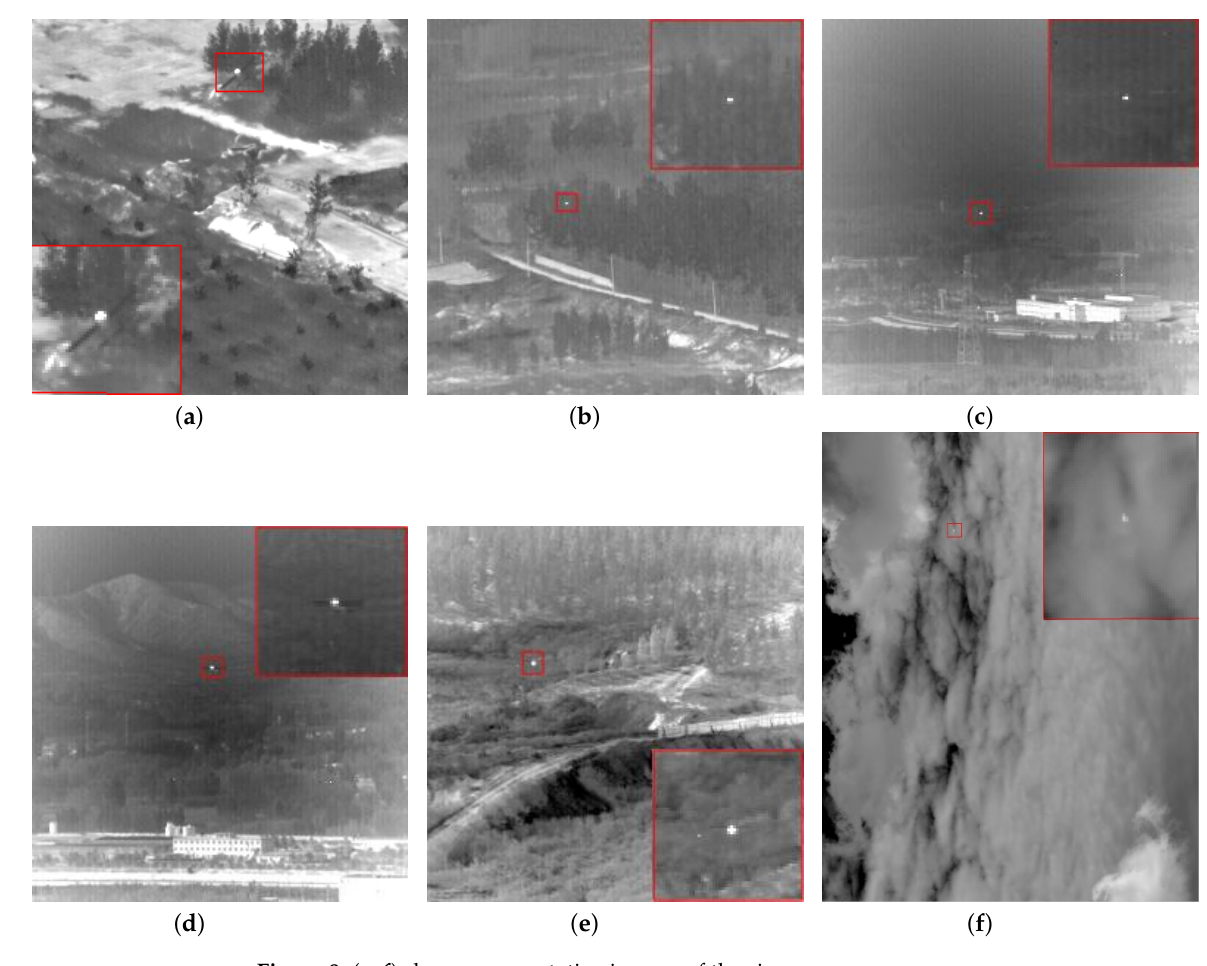
Figure 8. ( a – f ) show representative images of the six sequences. Table 3. Descriptions of the sequence